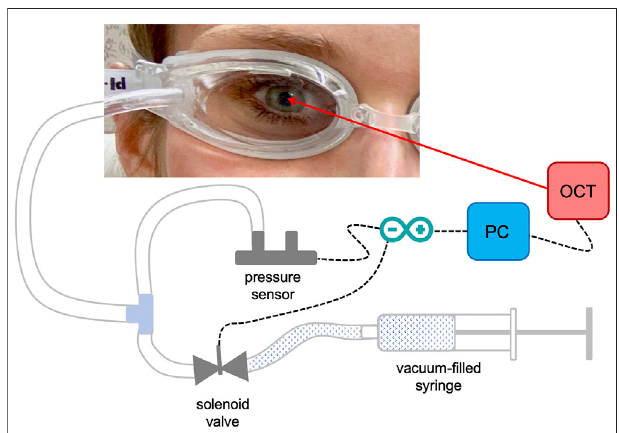
FIGURE 1 | Detail of the set-up used for the measurements. Ambient pressure modulation is performed by triggering the opening of the solenoid valve, which is connected to a vacuum- fi lled syringe, during the OCT measurement. The differential pressure sensor records the induced pressure modulation, which is in the order of diurnal physiologic IOP